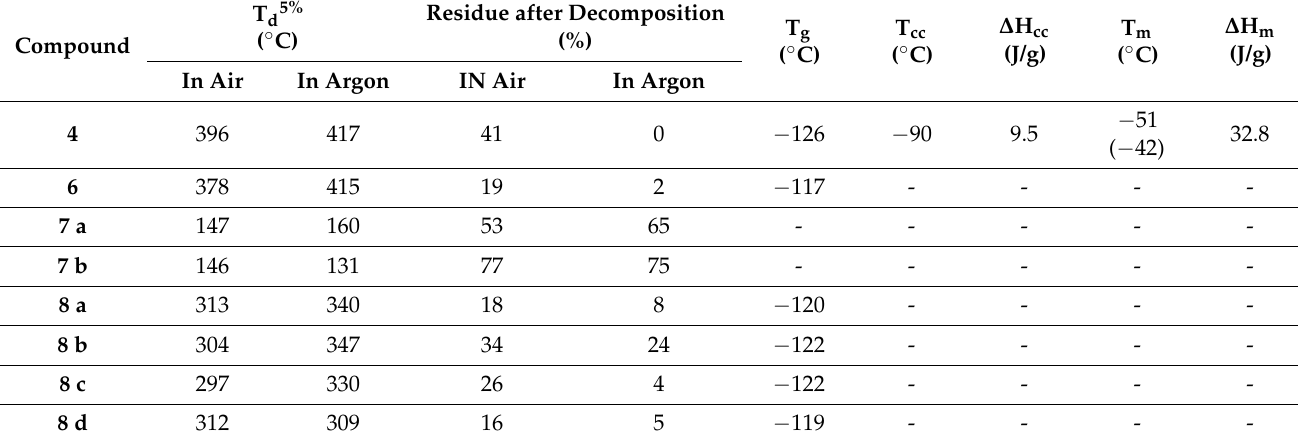
Table 3. Thermal properties of cross-linked polymers and